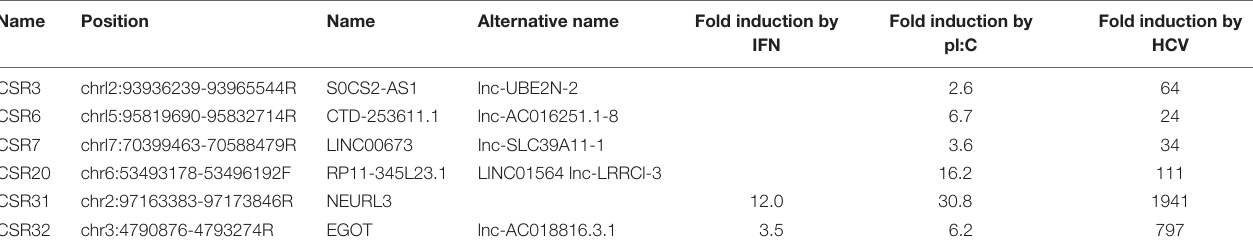
TABLE 2 | List of lncRNAs induced by HCV and